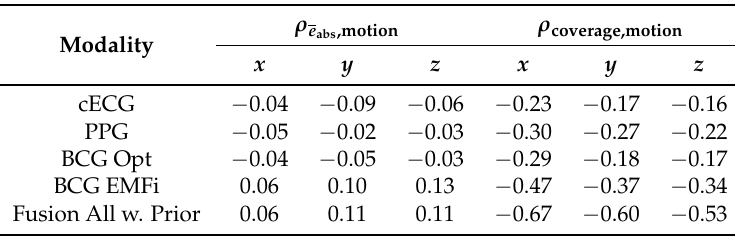
Table 5. Correlation coefficient between motion and estimation error as well as motion and coverage for all modalities and coordinate